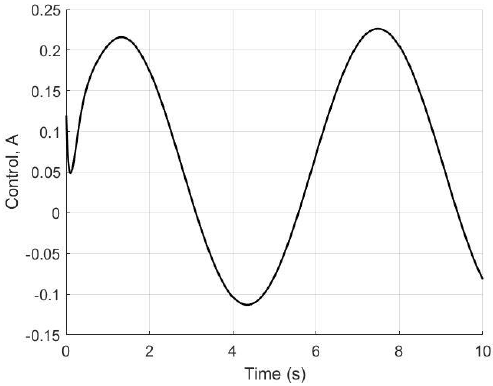
Figure 5. Experiment 1. Plot of the control u ( t ) .